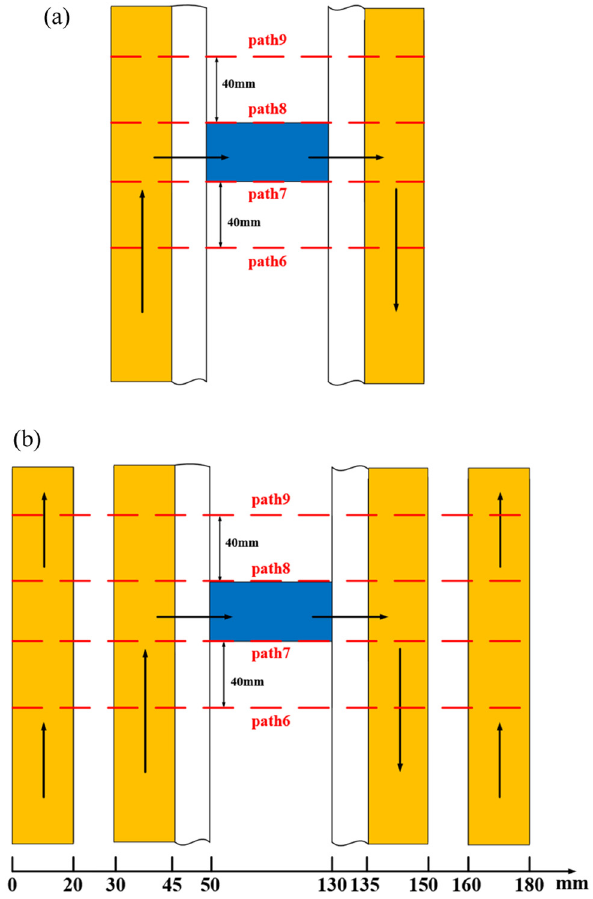
Figure 15: Map of the location of four paths. ( a ) Four paths of the standard CFREL and ( b ) four paths of the proposed